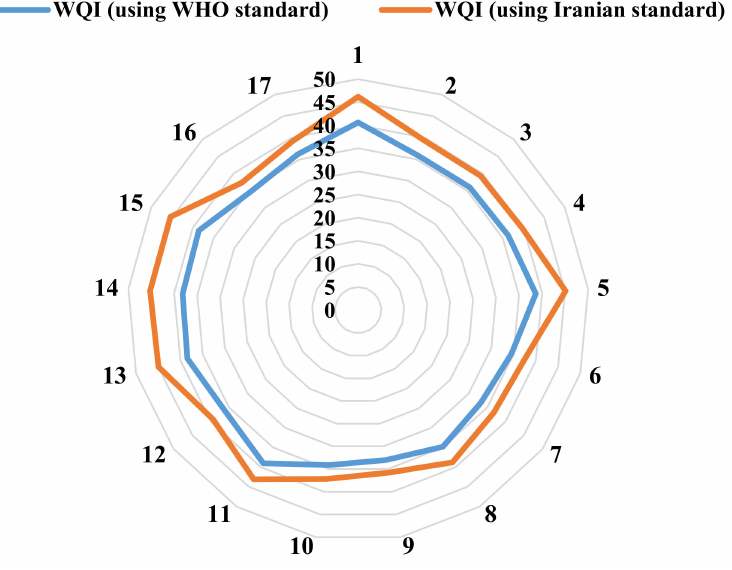
Figure 4. Water quality index (WQI) values in the sampling